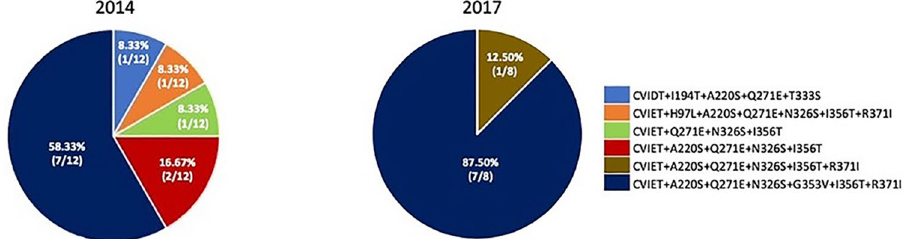
Figure 3. Pie charts representing haplotypes of pfcrt gene were observed in 12 P. falciparum isolates from Ubon Ratchathani in 2014 and 8 P. falciparum isolates from Ubon Ratchathani in